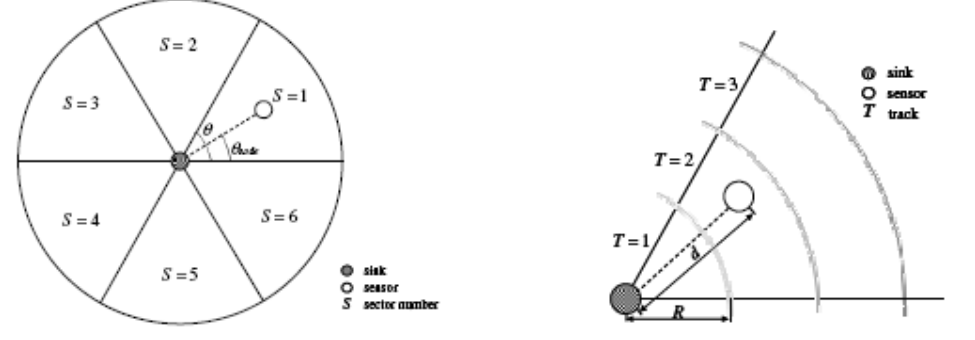
Figure 8. Direction angle and sector number [38]. Figure 9. Track number